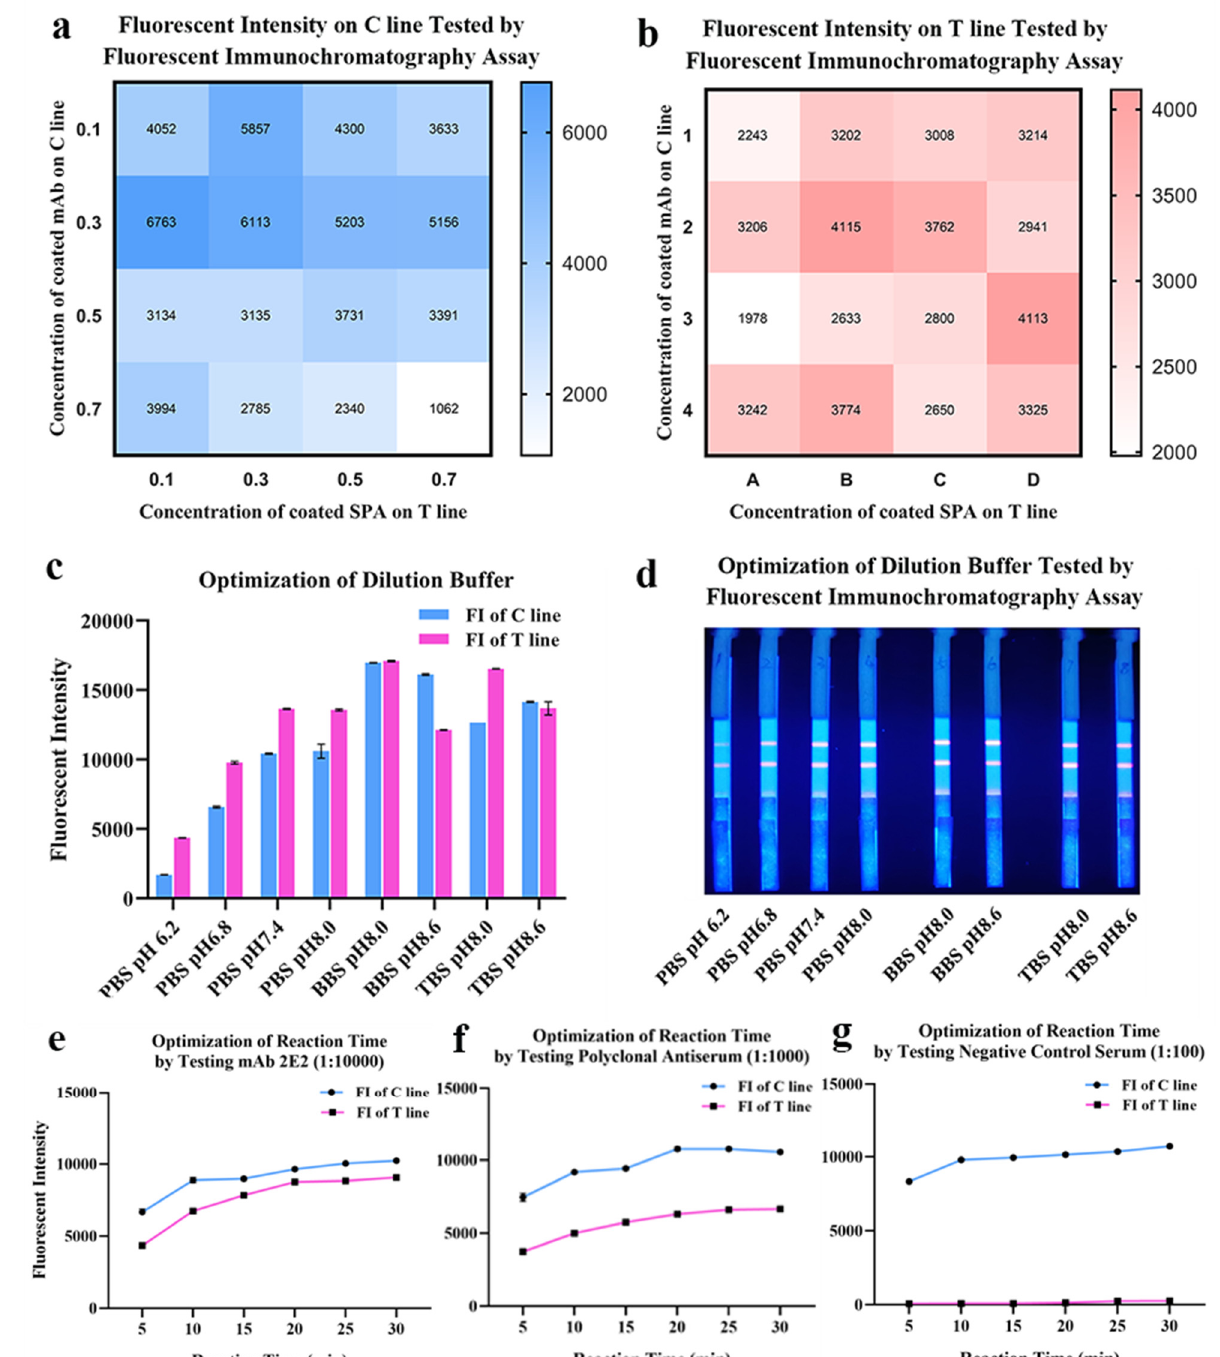
Figure 4. Optimization of coating concentrations, pH and buffer solution of the lateral flow assay. ( a , b ) Optimization of coated mAbs and SPA on the T line and the C line. The fluorescent intensity data was presented by heat map. ( c , d ) Optimization of the dilution buffer and pH. ( e – g ) Optimization of reaction time by testing mAbs, antiserum and negative control.